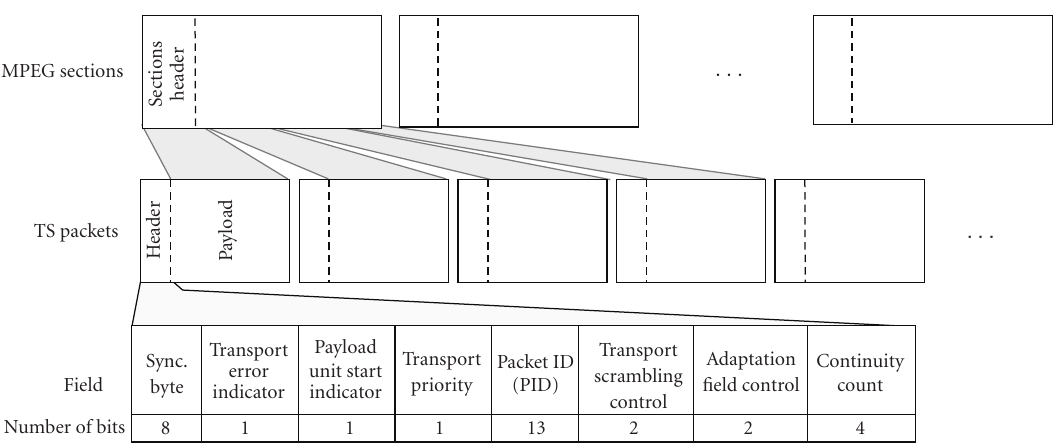
Figure 9: Sections split into transport stream packets.